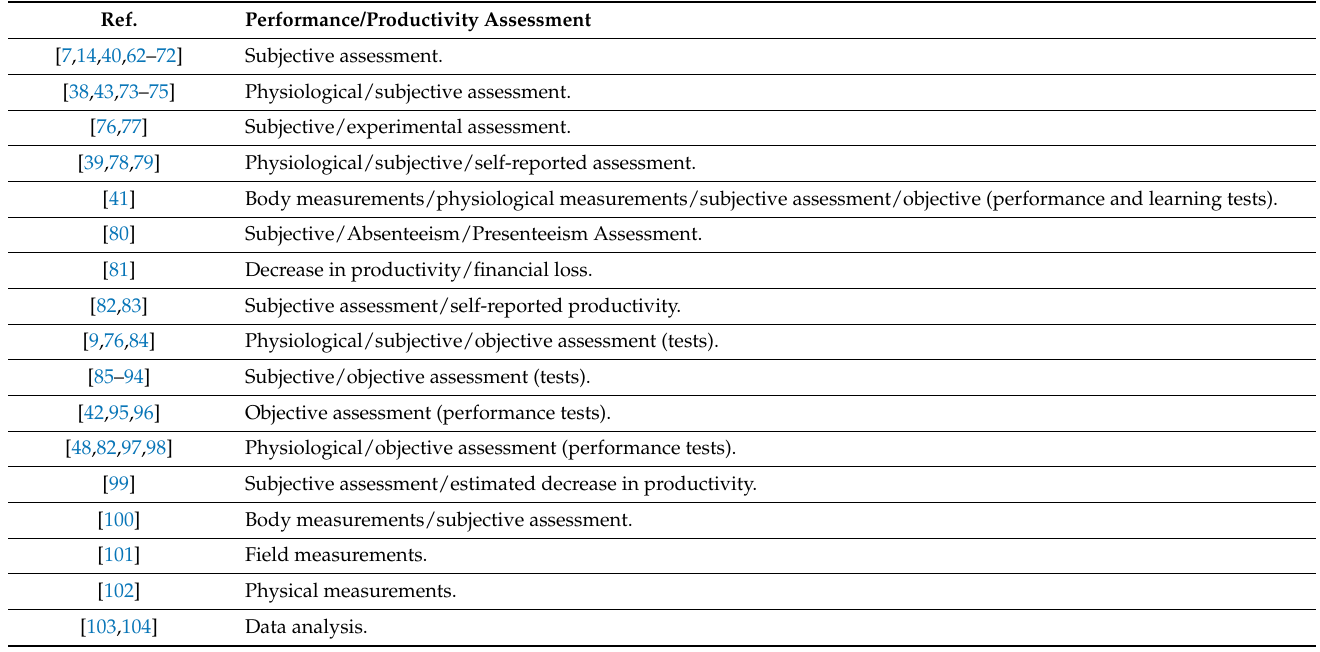
Table 4. Performance/productivity